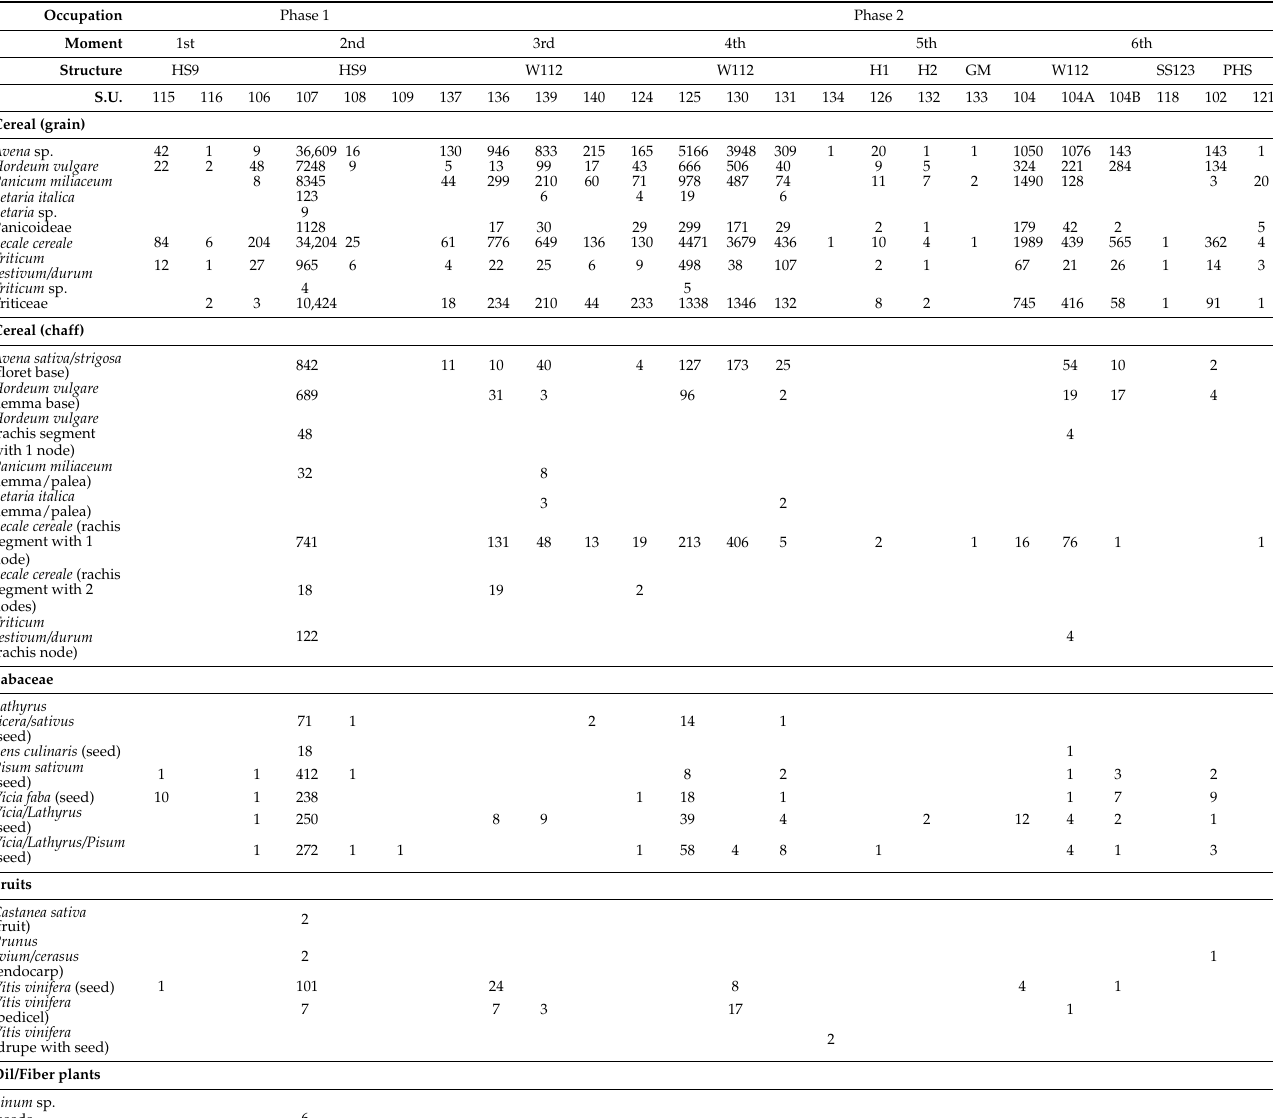
Table 3. Fruits/Seeds of crops and likely cultivated